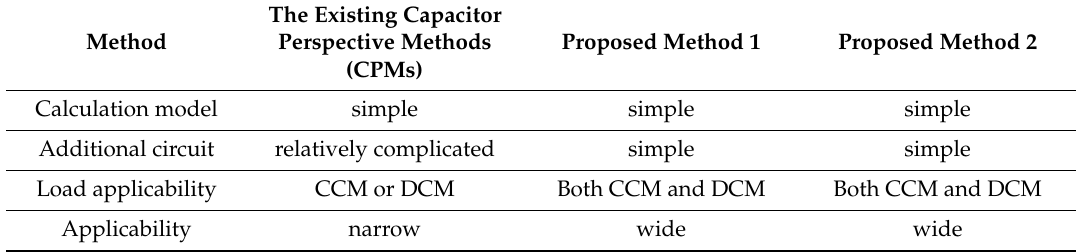
Table 7. Comparison between the Proposed Methods and the Existing